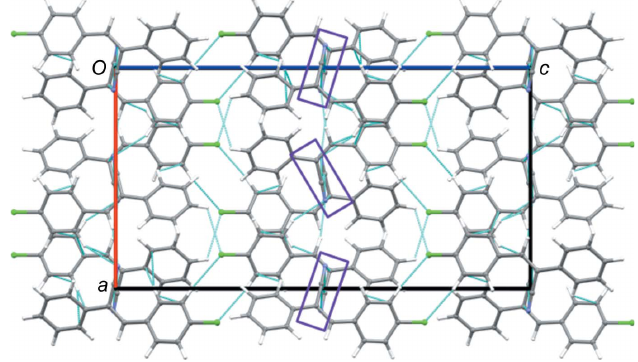
Figure 3 Aview along the b axis of the crystal packing of compound I , showing the nitrile stacking in the purple rectangles.